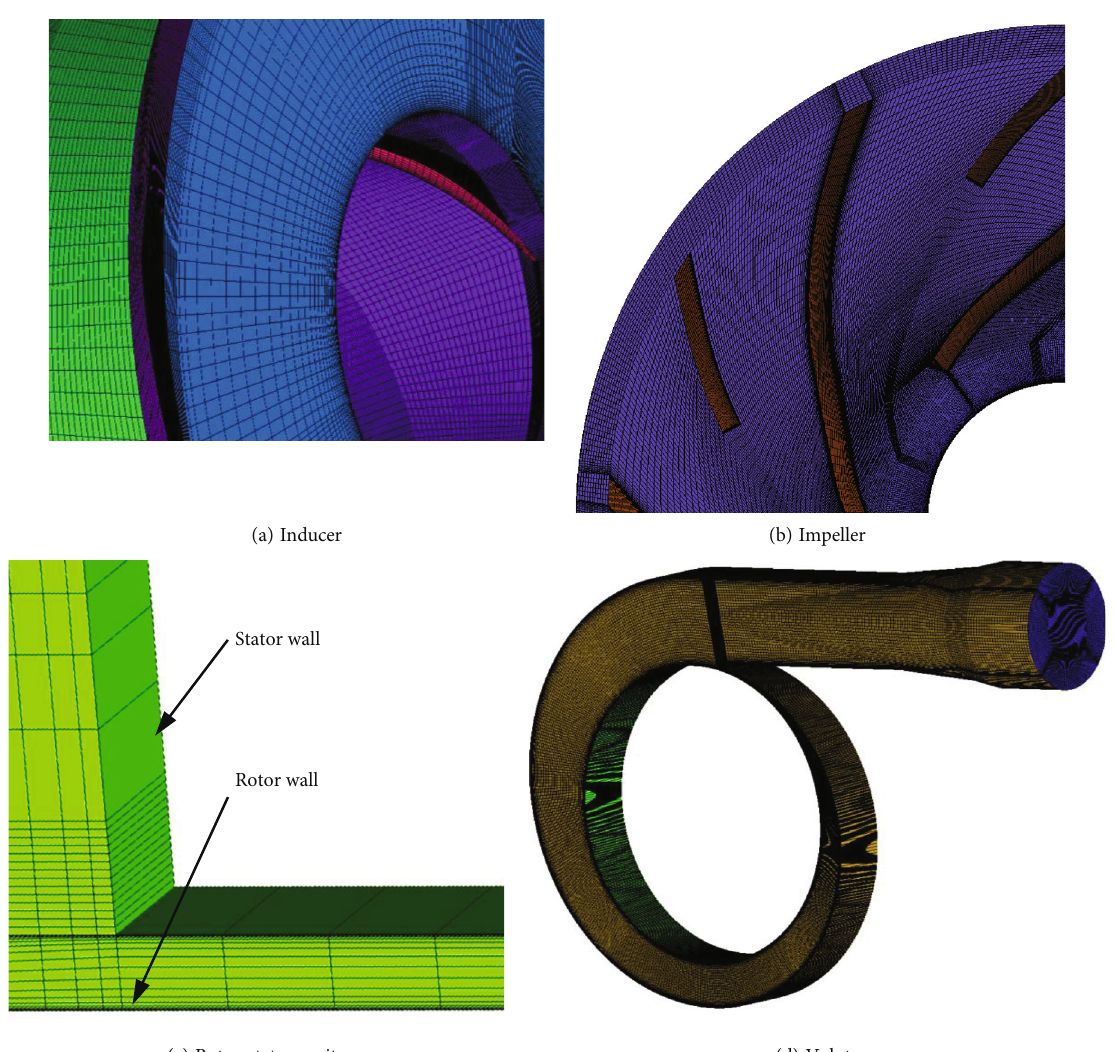
Figure 5: Mesh arrangement of the